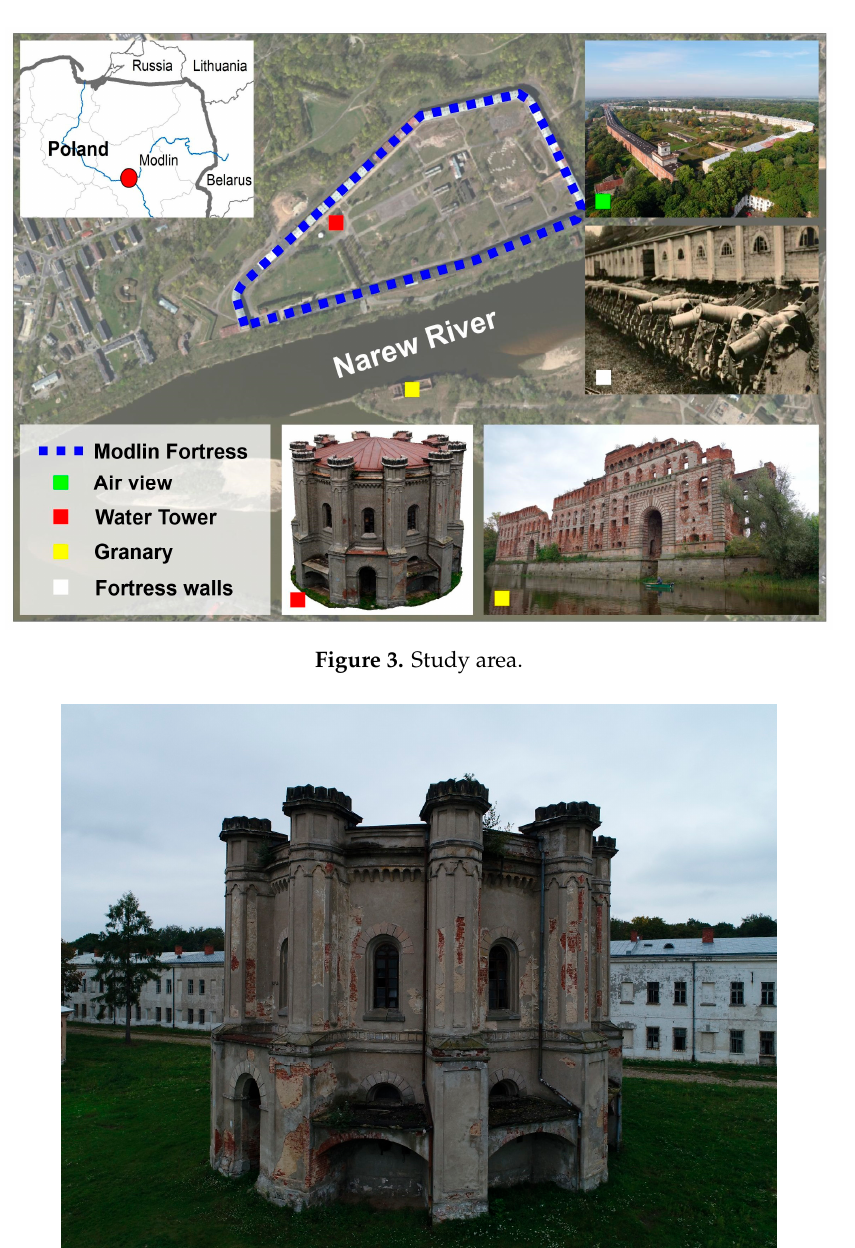
Figure 4. The water tower inside Modlin fortress—recent look.